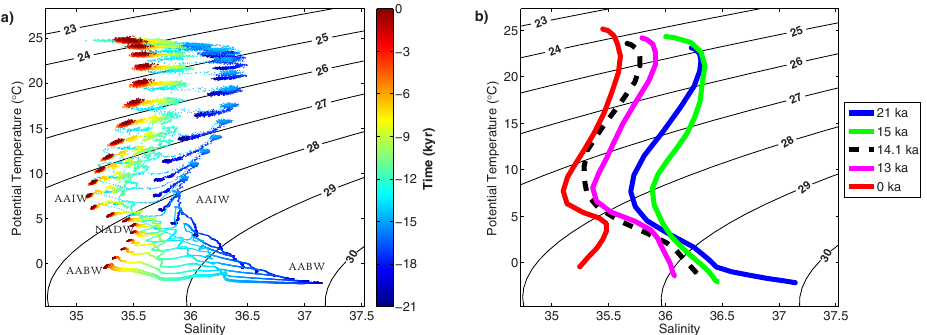
Figure 5. TraCE-21K θ –S diagram averaged between 30 ◦ S to 0 ◦ , at 25 ◦ W. Time evolution is represented by the color range (a) . The acronyms indicate the main water masses: AAIW – Antarctic Intermediate Water; AABW – Antarctic Bottom Water; NADW – North Atlantic Deep Water. The θ –S diagram for the key climatic periods considered in this study: LGM (21ka), before (15ka), during (14.1ka), after (13ka) MWP-1A and 0ka (b)